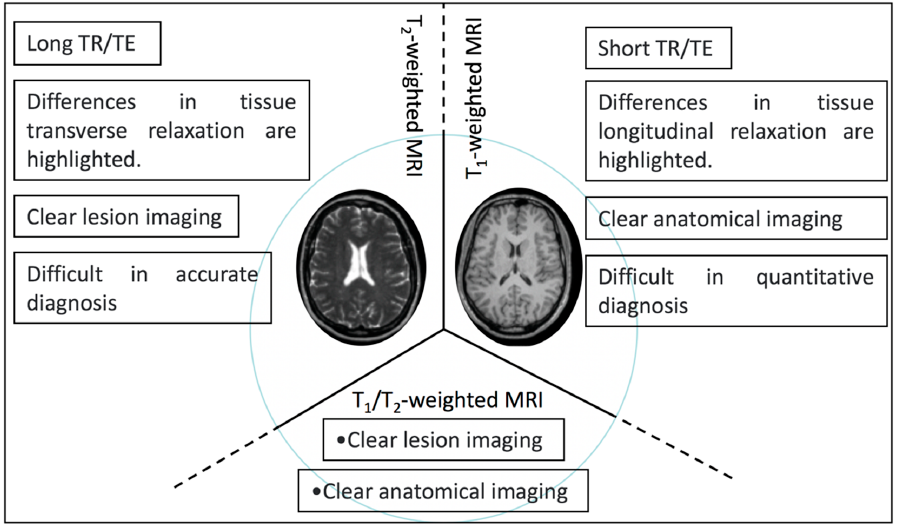
Scheme 2. Schematic illustration of the characteristics of T 1 -, T 2 -, and T 1 /T 2 -weighted